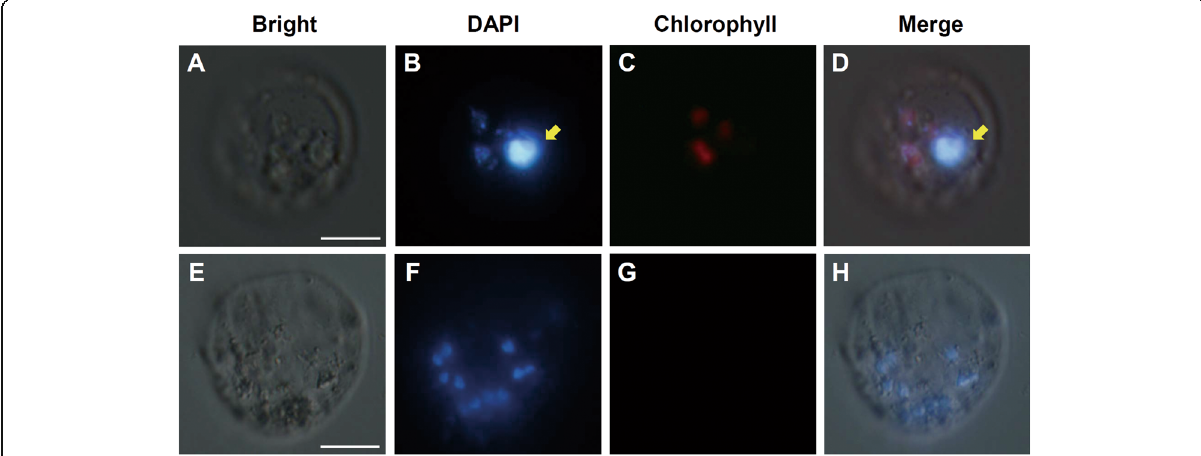
Fig. 5 Observation of DAPI-stained plastid nucleoids in the protoplasts isolated from leaves of wild-type and obgc1-d1 mutant plants. Morphological changes in plastid nucleoids were observed by DAPI staining, using protoplasts isolated from leaves of wild-type ( A - D ) and obgc1-d1 mutant ( E - H ) plants. Protoplasts were isolated from leaves of 10-day-old rice seedlings. Signals corresponding to nuclei are indicated by yellow arrows. Bars in the bright images, ( A ) and ( E ), represent 50 μ m in length